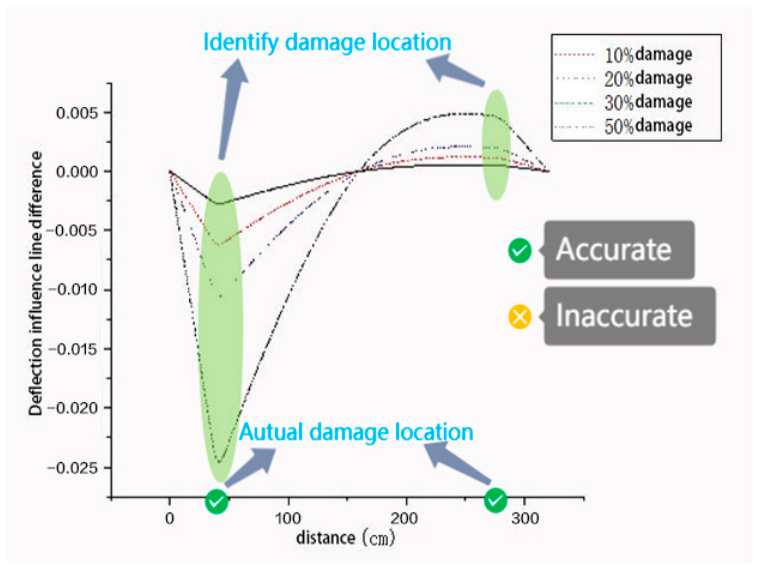
Figure 16. Deflection influence line difference of 25/100 determining point of the 1st span following work condition 1 (2-5).